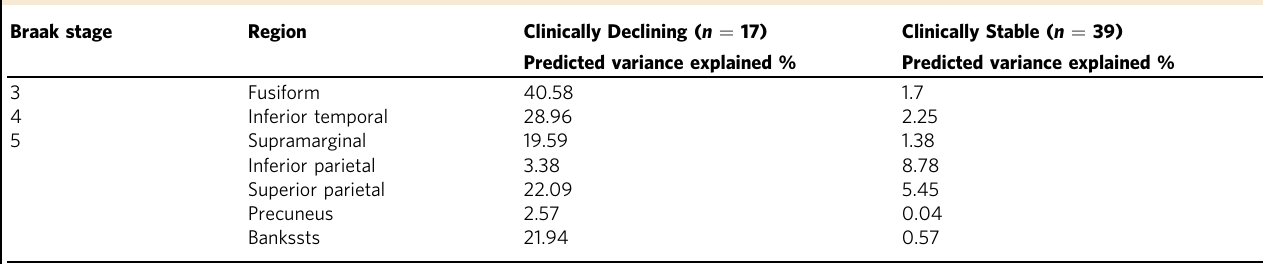
Fig. 7 Prediction accuracy of future tau accumulation in the BACS Clinically Declining sample. Comparing predicted tau accumulation to observed tau accumulation for individuals classi fi ed as Clinically Declining in the BACS cohort. a Fit of the predicted future rate of tau accumulation to the observed tau accumulation within the fusiform gyrus ( R 2 = 41%). The central black line indicates the regression line for the fi t of predicted vs. observed future rate of tau accumulation; the dashed lines indicate the 95% con fi dence intervals for this regression line. One outlier based on the scalar projection is not shown. b Percentage of shared variance of the predicted regional future tau accumulation and the observed future tau accumulation for Clinically Declining individuals within each of the selected ROIs (Fig. 6a). Source data are provided as a Source Data fi le. Table 1 Predicting regional future annualised tau accumulation in BACS.